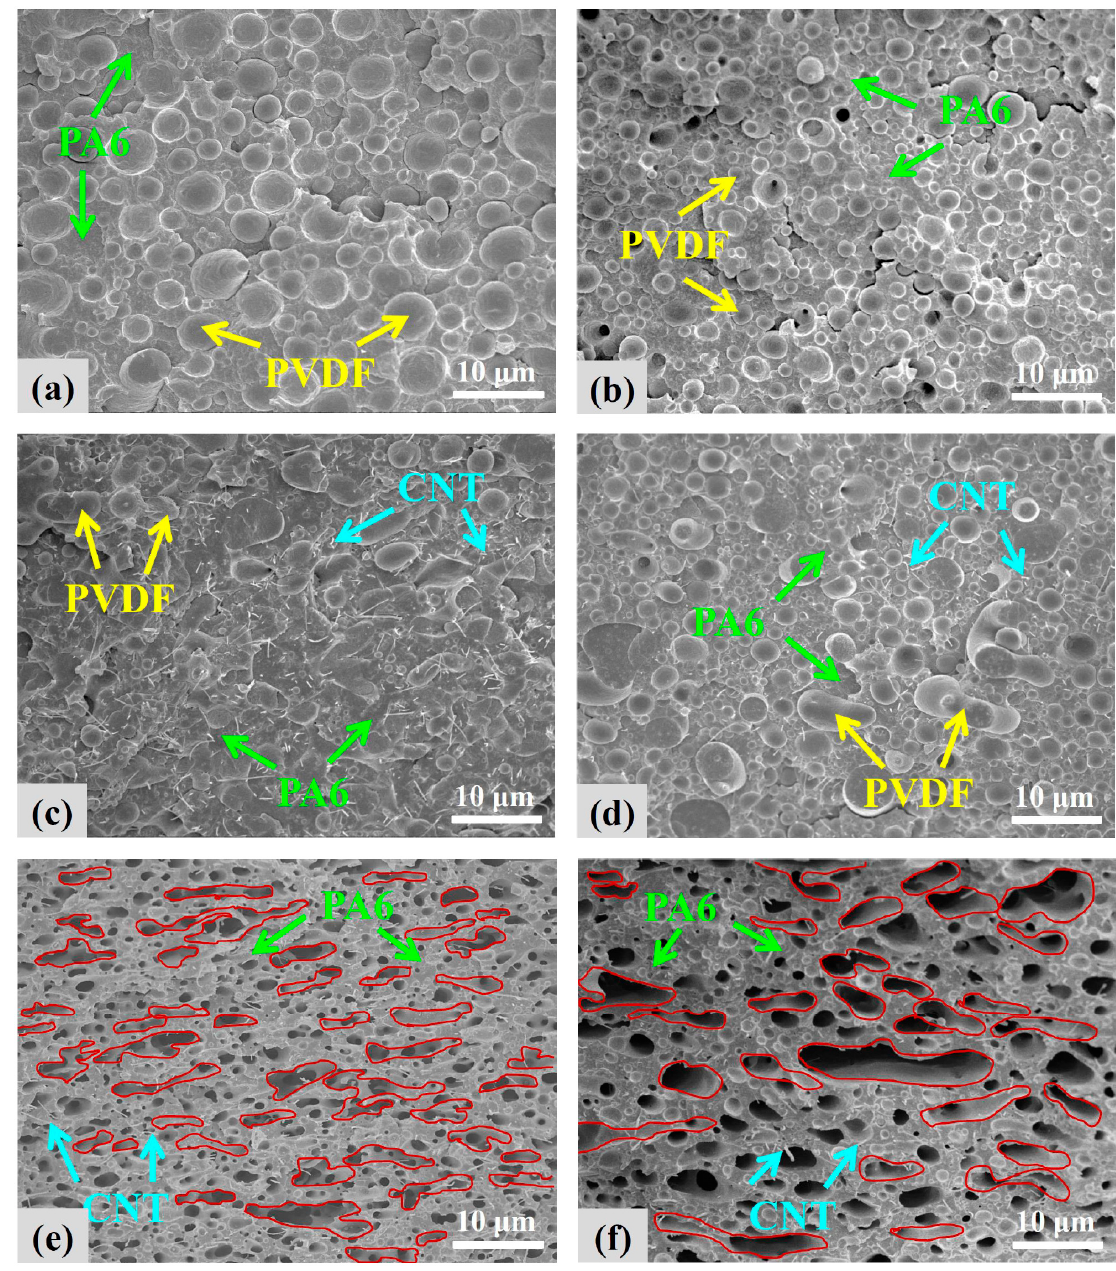
Figure 1. FESEM images of the samples: ( a ) A5F5, ( b ) A5F5C2, ( c ) A5F5T2, ( d ) A5F5C1T1, and PVDF- etched ( e ) A5F5T2, and ( f )